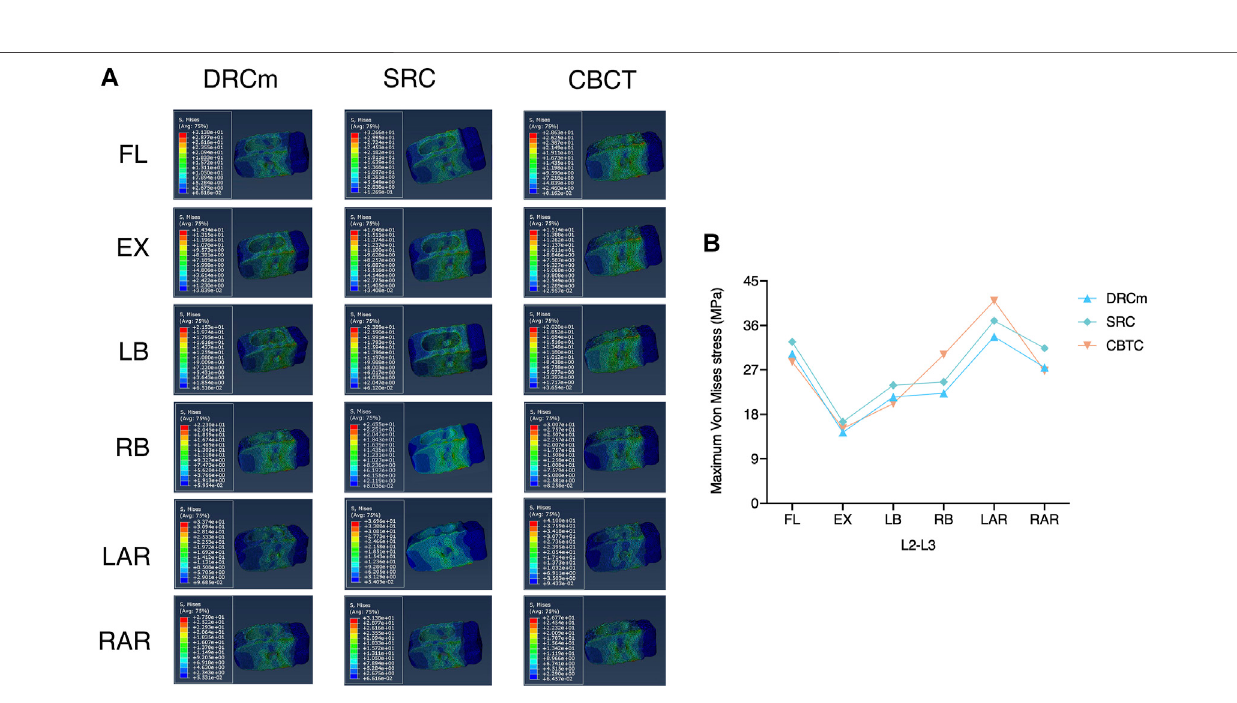
Frontiers in Bioengineering and Biotechnology |